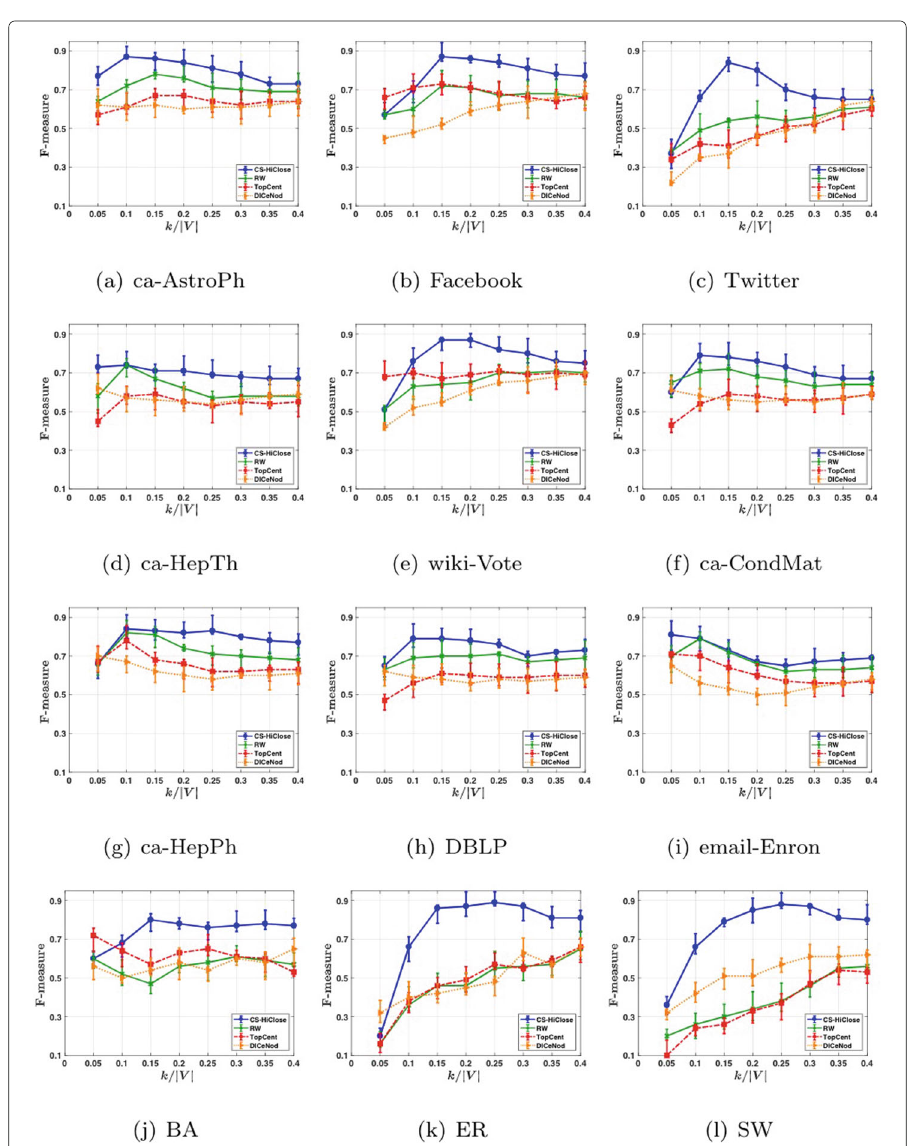
Fig. 3 Effect of sparsity level k on the accuracy of CS-H I C LOSE and the competing methods for the number of correctly detected top- k closeness centrality nodes. For all methods, we set the number of measurements to 0.4 | V | and the measurements length to 0.25 | V | . The higher the value of F-measure is, the more correlation between the top- k nodes list identified by a method and the global closeness centrality will be